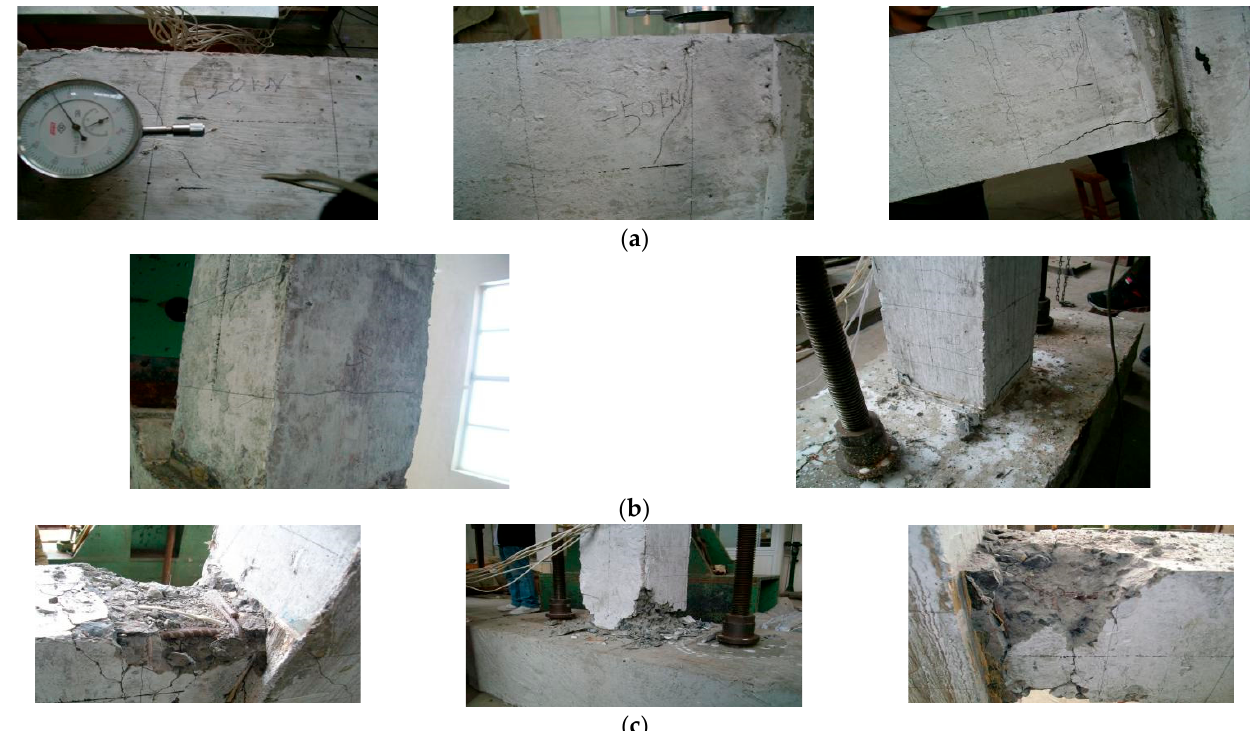
Figure 9. Experimental phenomenon diagram of KJ-1. ( a ) Cracks in the beams of KJ-1. ( b ) Cracks in the bottom of columns of KJ-1. ( c ) Failure modes of KJ-1.